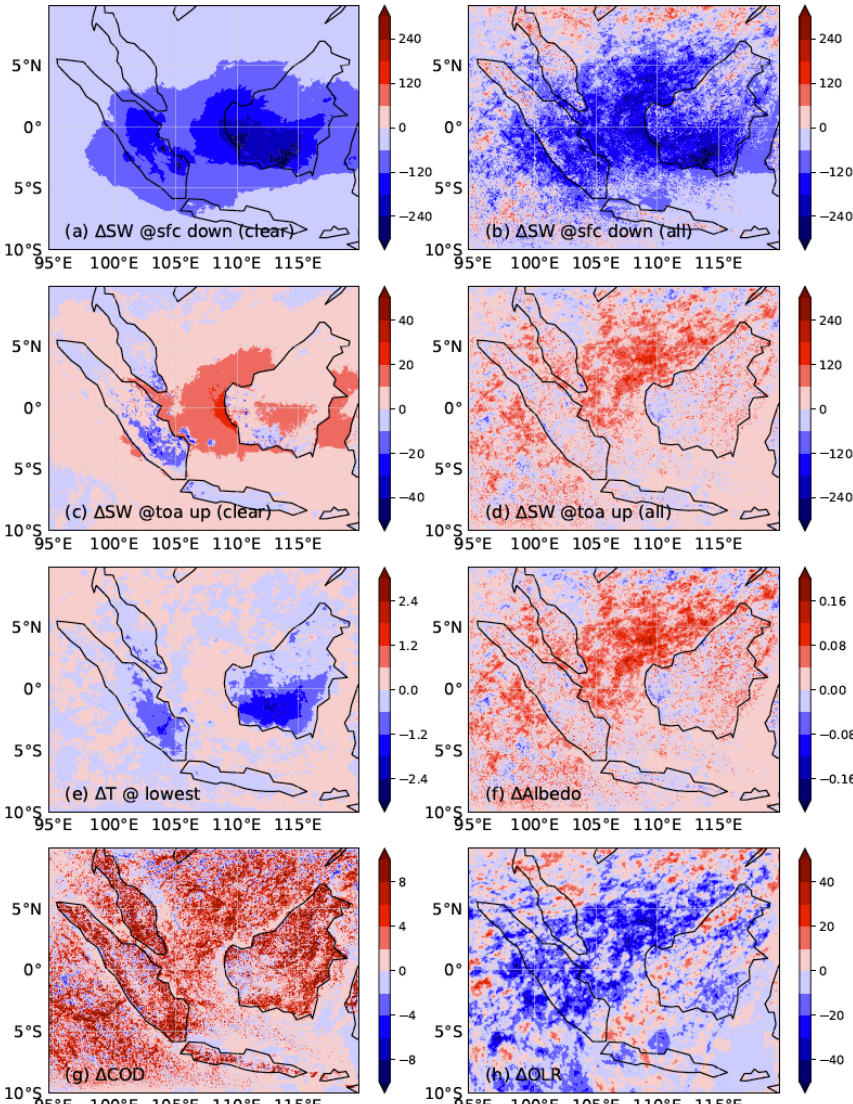
Figure 8. Simulated monthly mean differences (FIRE − NOFIRE) in (a) clear- and (b) all-sky downward shortwave radiation on the ground (Wm − 2 ), (c) clear- and (d) all-sky upward shortwave radiation at the top of the atmosphere (Wm − 2 ), (e) temperature at the low- est model level (K), (f) albedo (unitless), (g) estimated cloud optical depth (unitless), and (h) OLR (Wm − 2 ). These are the averages of differences at 06:00UTC (around local midday) every day in the month of September